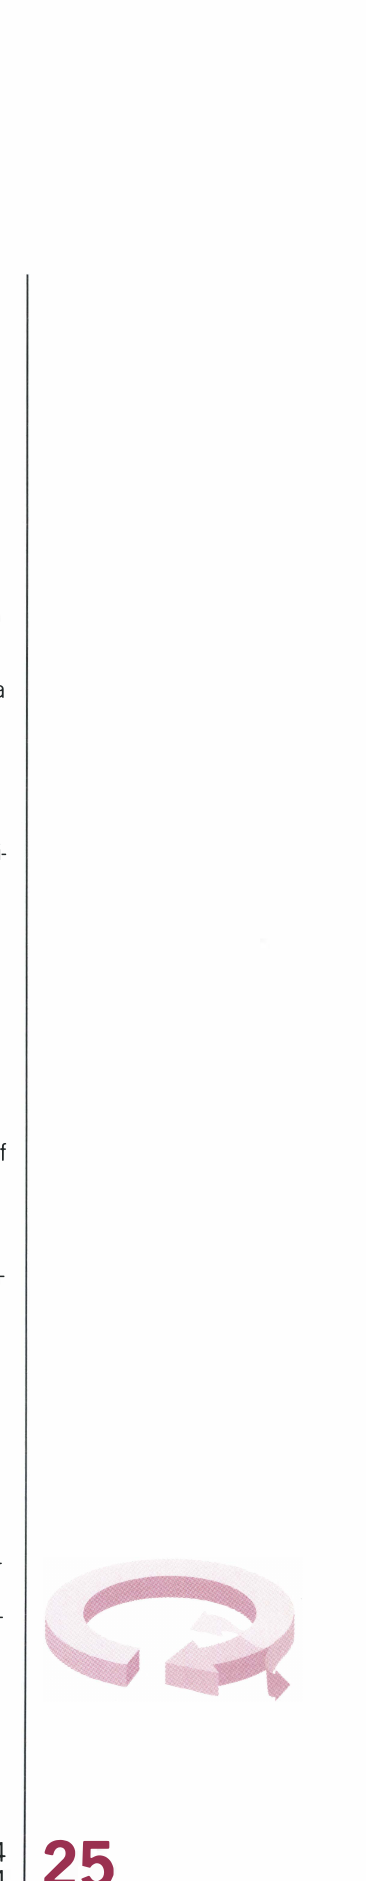
Fig. 4: Compliance effects as a function of angular frequency